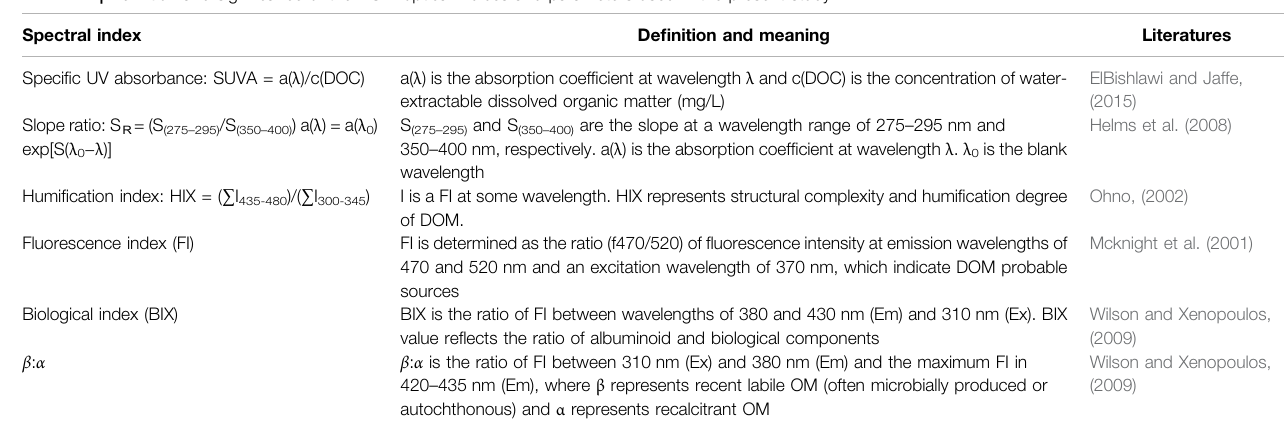
TABLE 2 | De fi nition and signi fi cance of the DOM optical indices and parameters used in the present study. Spectral index De fi nition and